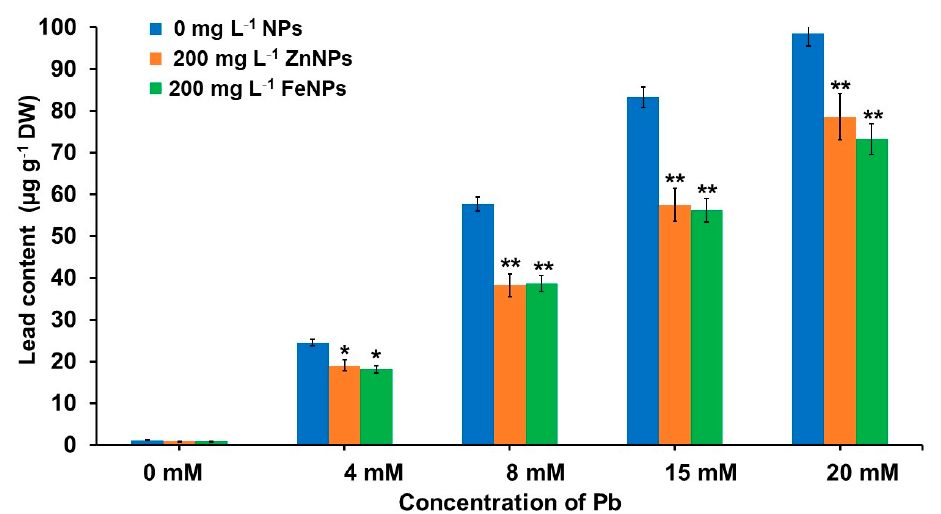
Figure 4. Effects of Pb and nanoparticles (ZnNPs and FeNPs) on lead content of 20-day-old B. alba seedling. Error bars representing the standard error. Asterisks above the error bars denote significant differences between treatments in comparison to respective treatment without NPs (* = p value < 0.05 and ** = p value < 0.01, Duncan’s Multiple Range Test).